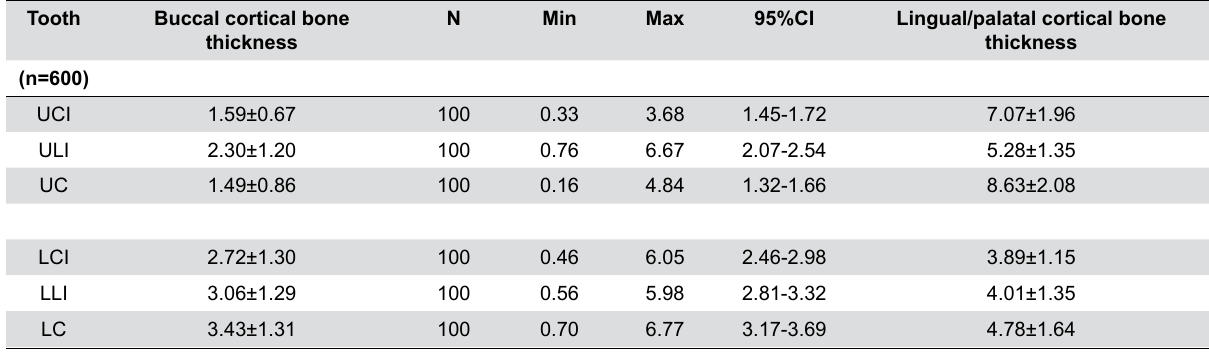
Table 1- Buccal and lingual/palatal bone thickness of maxillary and mandibular anterior teeth a,b, in the sagittal plane